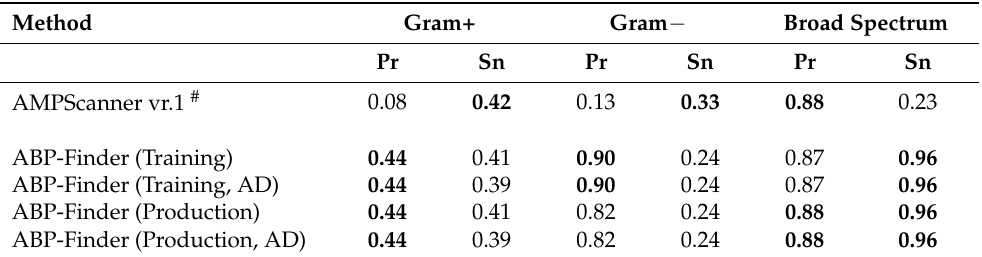
Table 6. Comparison of ABP-Finder with AMP-Scanner_v1 in the discrimination between Gram- staining classes within the test set. The values in bold denote the best performance for a given measure.